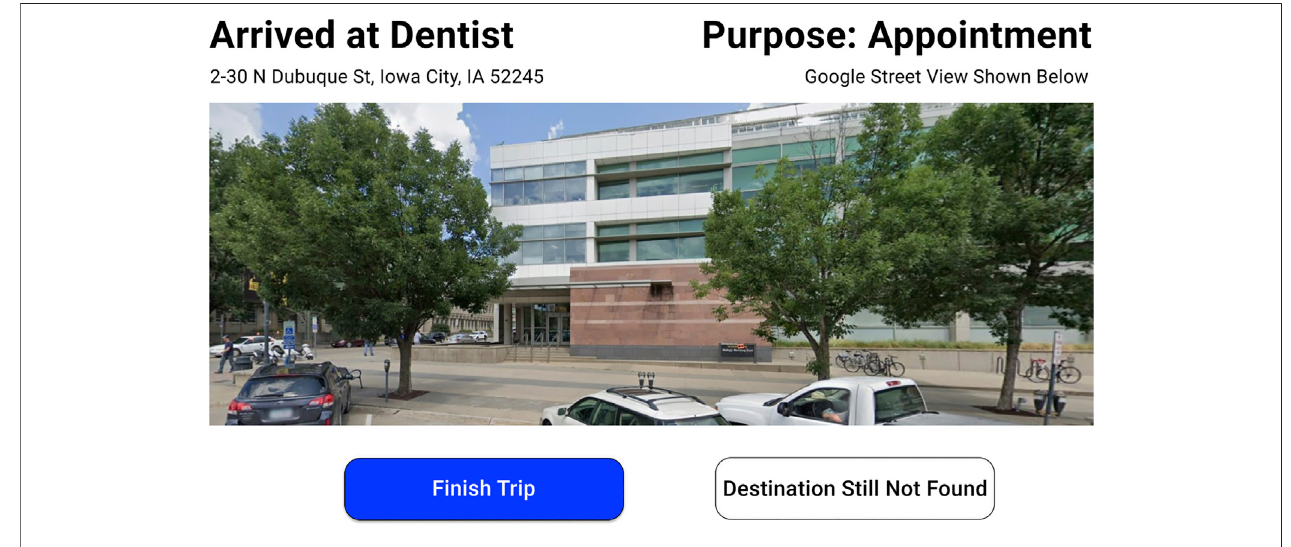
FIGURE 9 | Prototype of the arrival orientation reminder (Google Street